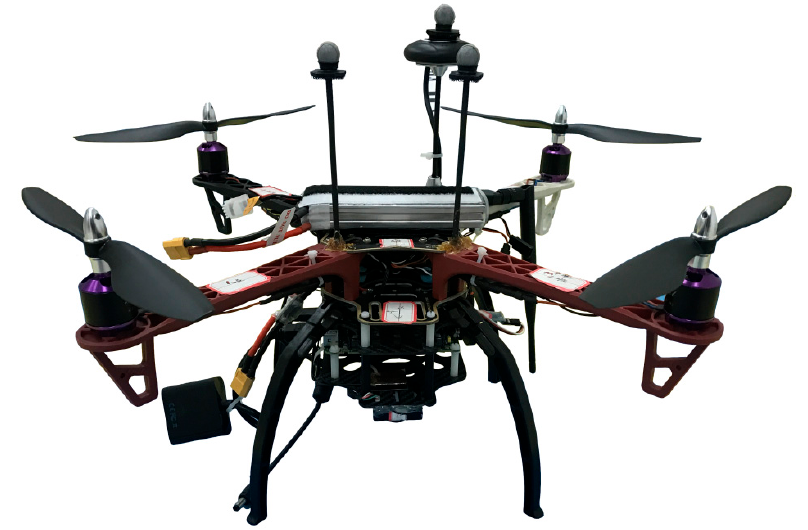
Figure 8. Overlook of the experimental platform in this paper.